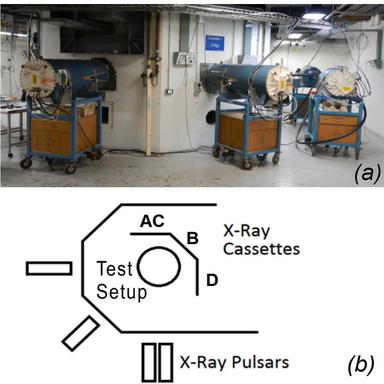
Flash X-ray instrumentation setup for the validation tests: general view outside the test chamber (a) and top view schematic of the test arena and X-ray setup (b).